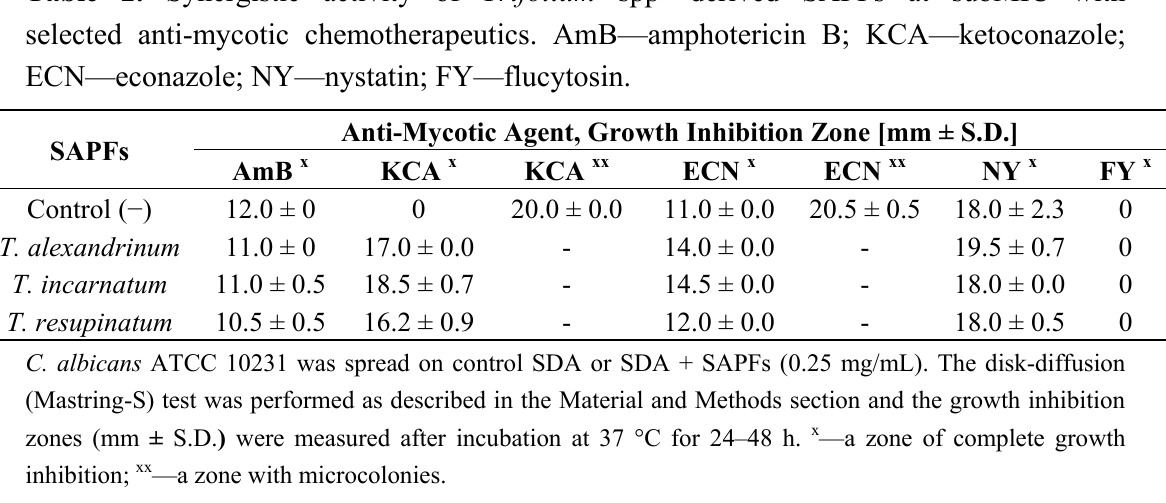
Table 2. Synergistic activity of Trifolium spp—derived SAPFs at subMIC